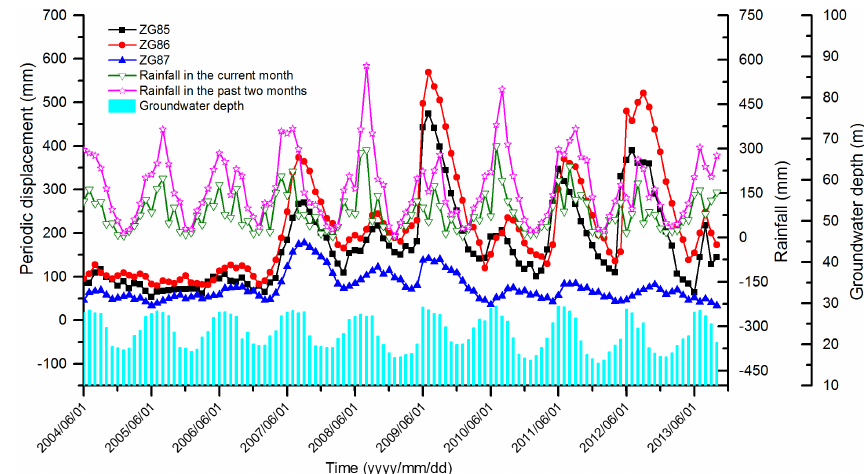
Figure 11. The relationships between rainfall, groundwater depth and periodic displacement at GPS monitoring